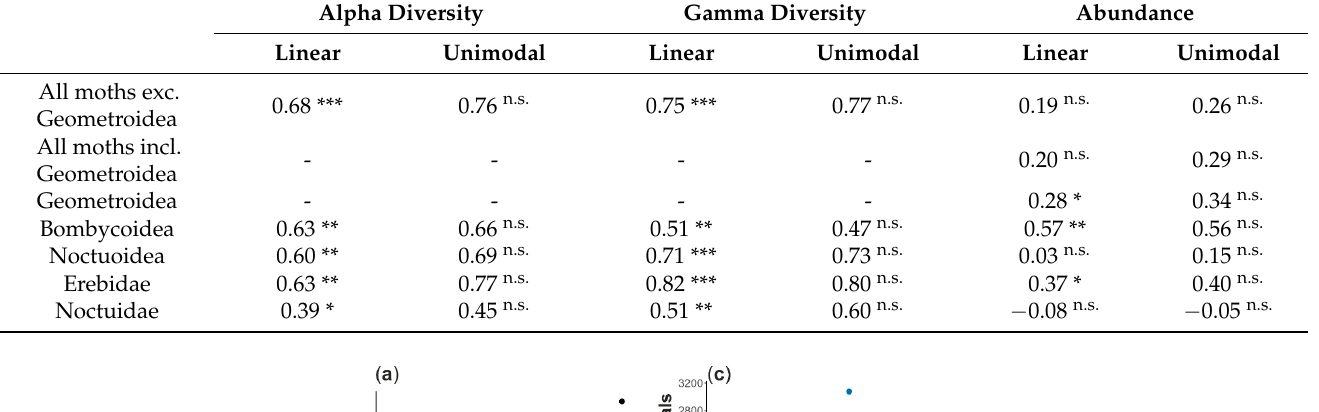
Table 3. Results of linear and unimodal models for relationship of moth diversity indexes (alpha diversity, gamma diversity, and abundance) to mean NDVI for each focal moth group. Coefficients of determination (R 2 ) are indicated, with the model p -values ( n.s. p ≥ 0.05, * p < 0.05; ** p < 0.01, *** p < 0.001).